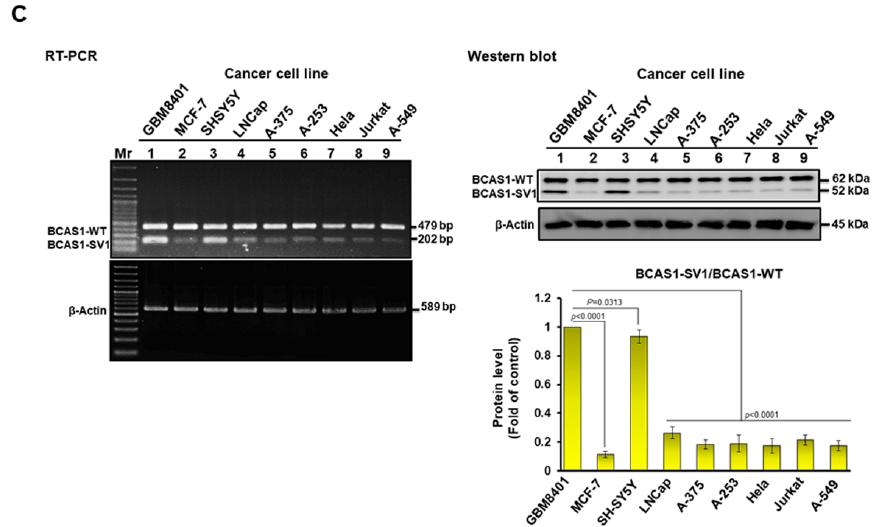
Figure 1. Identification of the novel BCAS1-SV1 splice variant. ( A ) Simplified transcript structures of BCAS1 and BCAS1-SV1. The BCAS1 gene is composed of 12 exons. The BCAS1-SV1 transcript deletes exons 1, 2, and 3 (47 codons, blue marked letters on the left) as well as exons 8, 9, and 10 (92 codons, blue marked letters on the right) but has an added exon 1.1 (5 codons, green marked letters on the left) and exon 6.1 (45 codons, green marked letters on the right). ( B ) BCAS1-SV1 is highly expressed in six GBM cell lines but less so in three types of healthy brain cells, as shown by RT-PCR (upper right) and Western blot analysis (bottom right). Primers were designed on exon 7 and exon 11 to obtain products with 479 base pairs (bp) (BCAS1) and 202 bp (BCAS1-SV1) (left). β -actin was an internal control. ( C ) BCAS1-SV1 is less expressed in other cancer cell lines, as shown by RT-PCR (left) and Western blot analysis (right). β -actin was an internal control.